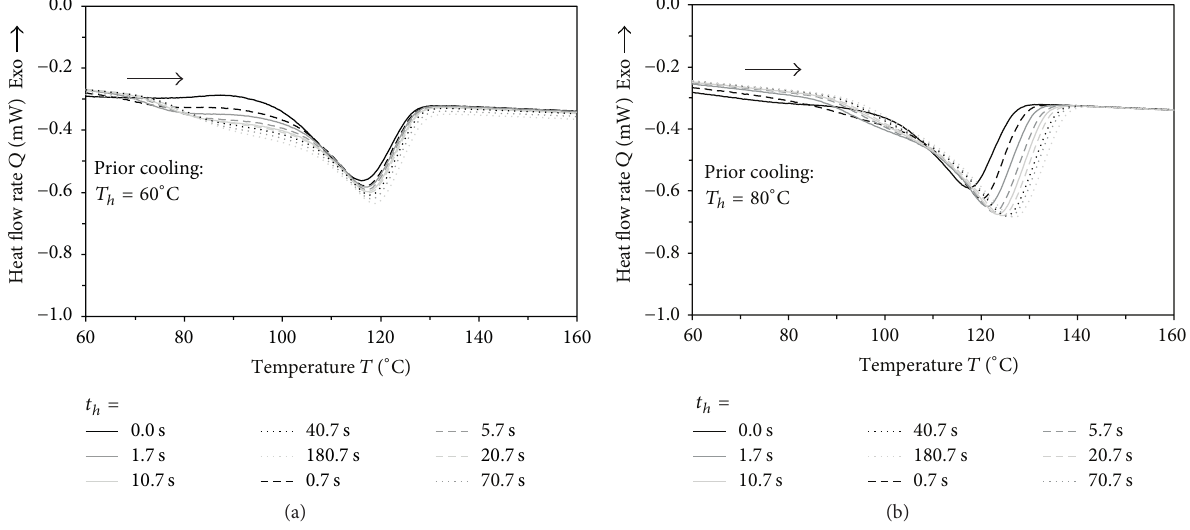
Figure 8: Heat flow rate measured during second heating of process-based cooled samples with isothermal holding step at 60 ∘ C (a) and 80 ∘ C